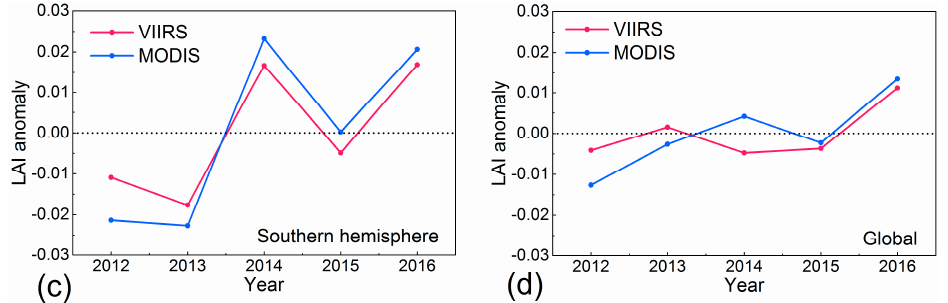
Figure 3. Time-series of annual LAI anomalies over 2012–2016 for VIIRS (red line) and MODIS (blue line). The values in figure ( a – d ) stand for the LAI anomaly in the Northern Hemisphere (25 ° N–90 ° N), equatorial region (25 ° N–25 ° S), Southern Hemisphere (25 ° S–90 ° S) and global vegetated area, respectively.